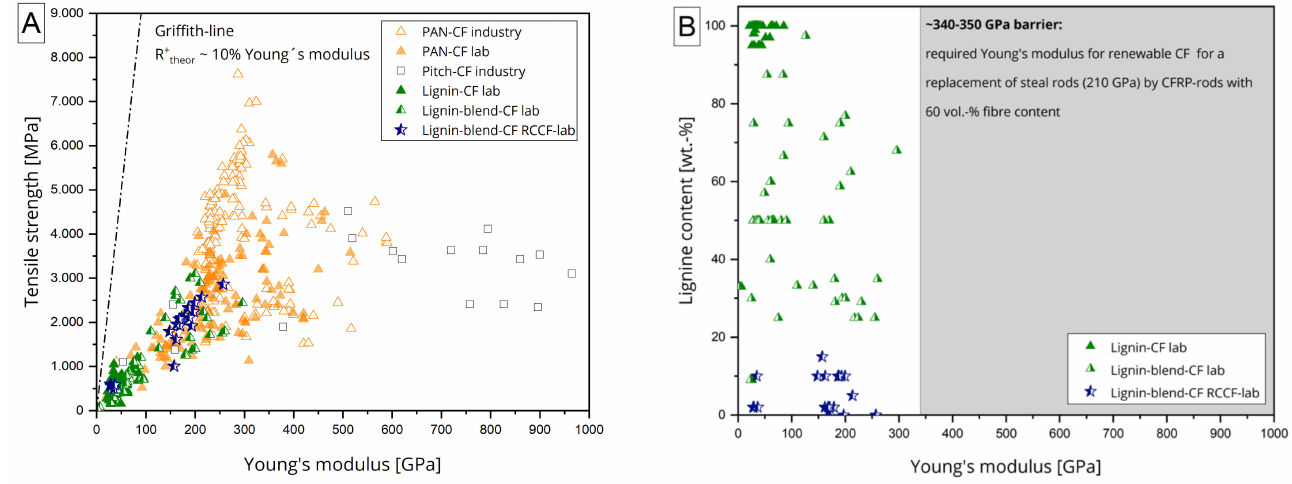
Figure 1. Overview of the mechanical properties of PAN-based, pitch-based, lignine-based, and lignine-blend-based carbon fibres with filament diameters above 3 µ m ( A ) and in case of lignin-based CF replacing steel rods with lignin-resin based CF-reinforced rods ( B